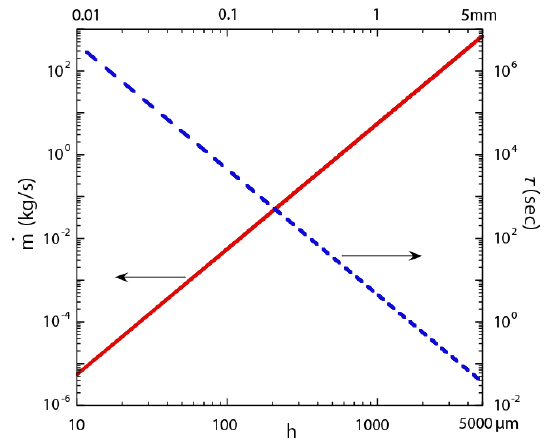
Figure 5. Mass flowrate requirement and available levitation time for a 2200-N Hyperloop pod.